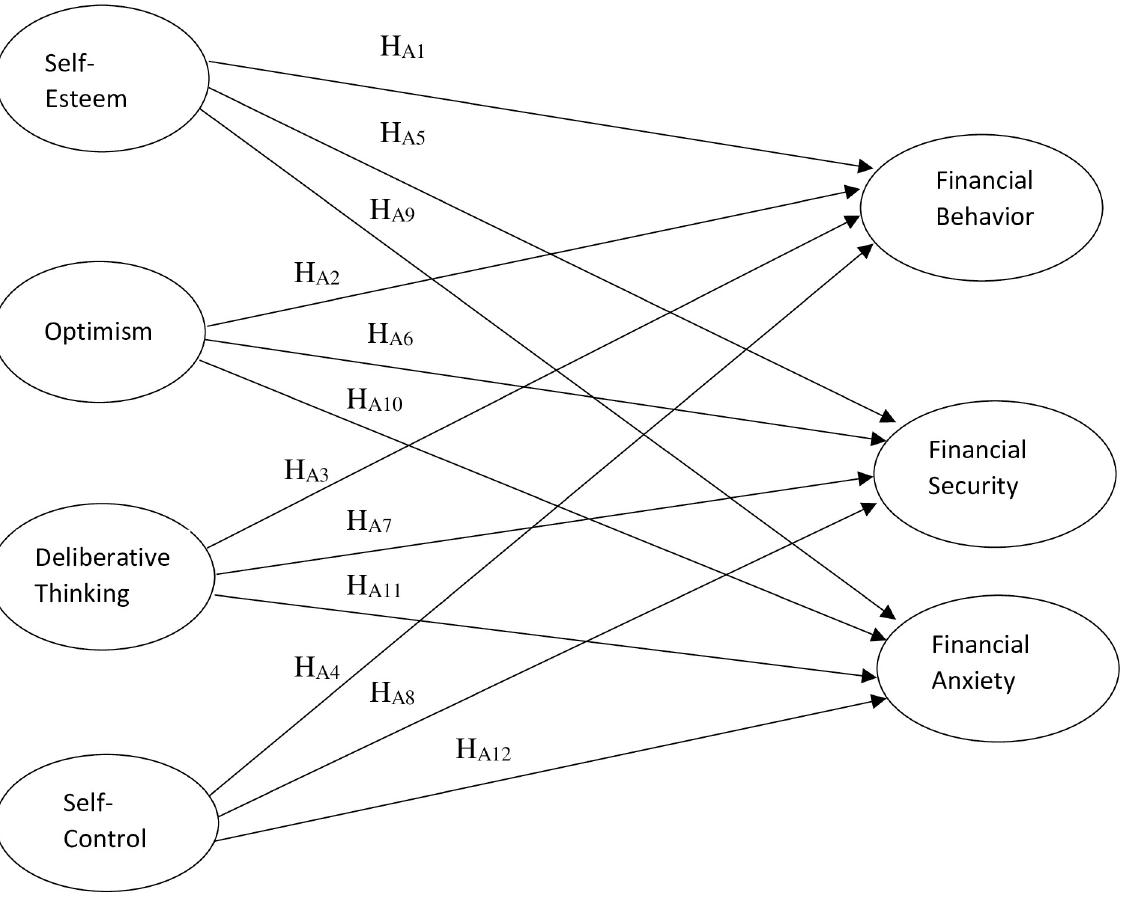
Fig 1. Conceptual framework of the